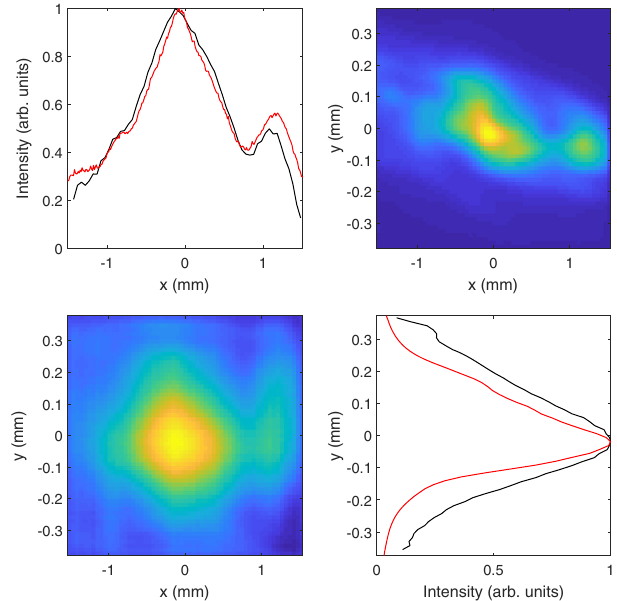
FIG. 38. Validation of results from phase space tomography in two d.o.f. in the CLARA FE. The plot at the top right shows the beam image observed directly on YAG-02; the plot at the bottom left shows the charge distribution in coordinate space recon- structed from phase space tomography in two d.o.f. (a projection of the four-dimensional phase space onto the coordinate plane). The plots at the top left and bottom right show the charge density projected onto the horizontal and vertical axes, respectively: Black lines are from the tomography analysis, and red lines are from the directly observed image.